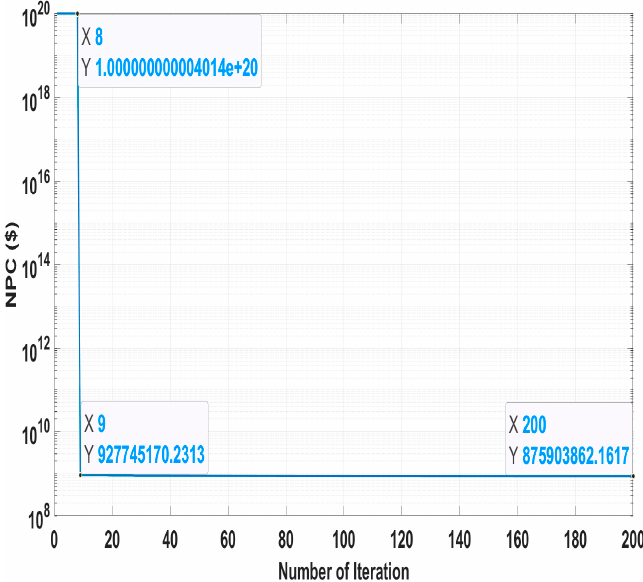
Figure 7. Convergence Plot (Case-02).